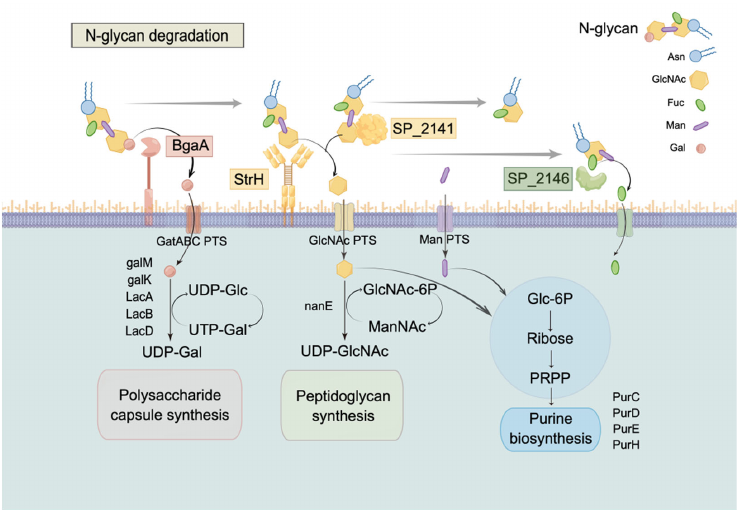
Figure 7. Schematic diagram of the inhibition of glycan biosynthesis by Tryptanthrin. Figure was illustrated by Figdraw (https://www.figdraw.com/, accessed on 5 November 2022). Above the mem ‐ brane line, the bgaA, strH, SP_2141, and SP_2146 exhibited their function of hydrolyzation on the N ‐ glycan degradation pathway. Below the membrane line, the monosaccharides were transported through PTS proteins into intracellular cells for peptidoglycan biosynthesis. The down ‐ stream pro ‐ teins related to carbon metabolism and cell wall or polysaccharide capsule biosynthesis were named as galK, galM, LacA, LacB, LacD, nanE, PurC, PurD, PurE, and PurH, which were also marked as down ‐ regulated proteins in the volcano plot of proteomics analysis. In conclusion, we found that the ethanol extract of S. cusia leaves, as well as its active compound Tryptanthrin, could inhibit PRSP’s growth. Tryptanthrin possibly targeted N ‐ glycan degradation ‐ related proteins and led to deficiency of cell wall and capsule biosyn ‐ thesis of PRSP. We assumed that the down ‐ regulated purine metabolism, galactose me ‐ tabolism, phosphotransferase system (PTS), amino sugar, and nucleotide sugar metabo ‐ lism were possibly affected by the inhibition of up ‐ stream targets we found from reverse docking of Tryptanthrin, including the N ‐ glycan degradation proteins BgaA (4cu6), StrH (4azi), SP_2141 (5a6a), and SP_2146 (6org). Given that during both colonization and inva ‐ sive disease, PRSP ferments host ‐ derived carbohydrates as its primary means of generat ‐ ing energy [2], our findings also indicated that ES inhibited part of nutrient acquisition function of PRSP by blocking its N ‐ glycan degradation enzymes, which therefore dimin ‐ ished available monosaccharide for its own growth, especially for the cell wall and capsule synthesis. Our study not only provided the framework for future exploration to assess the mechanism of S. cusia leaves on clinical prophylaxis of PRSP caused infection, but also set up an example to delve into the pharmacological mechanism of TCM from both the crude extract and the single compound.